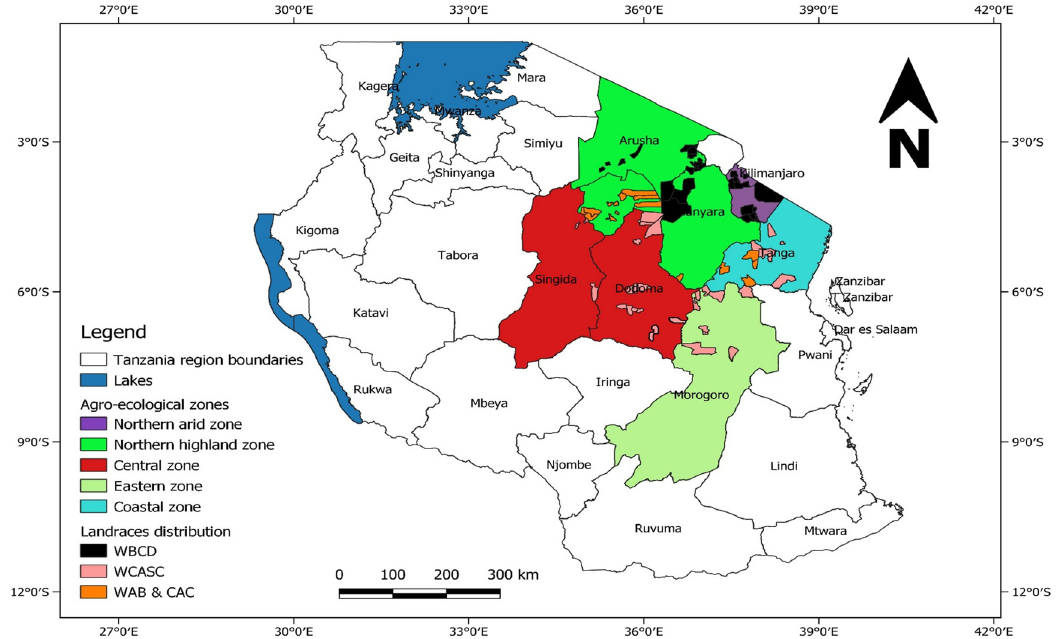
Figure 2: A map of Tanzania showing potential wards and villages in Lablab production along with seed color diversity in each of fi ve Lablab agro - ecological production zone: WBCD refers to the wards with black seeded cultivars dominating; WCASC refers to the wards with cultivars of all colored seeds; and WAB and CAC refers to the wards with high availability of black cultivars and less of other